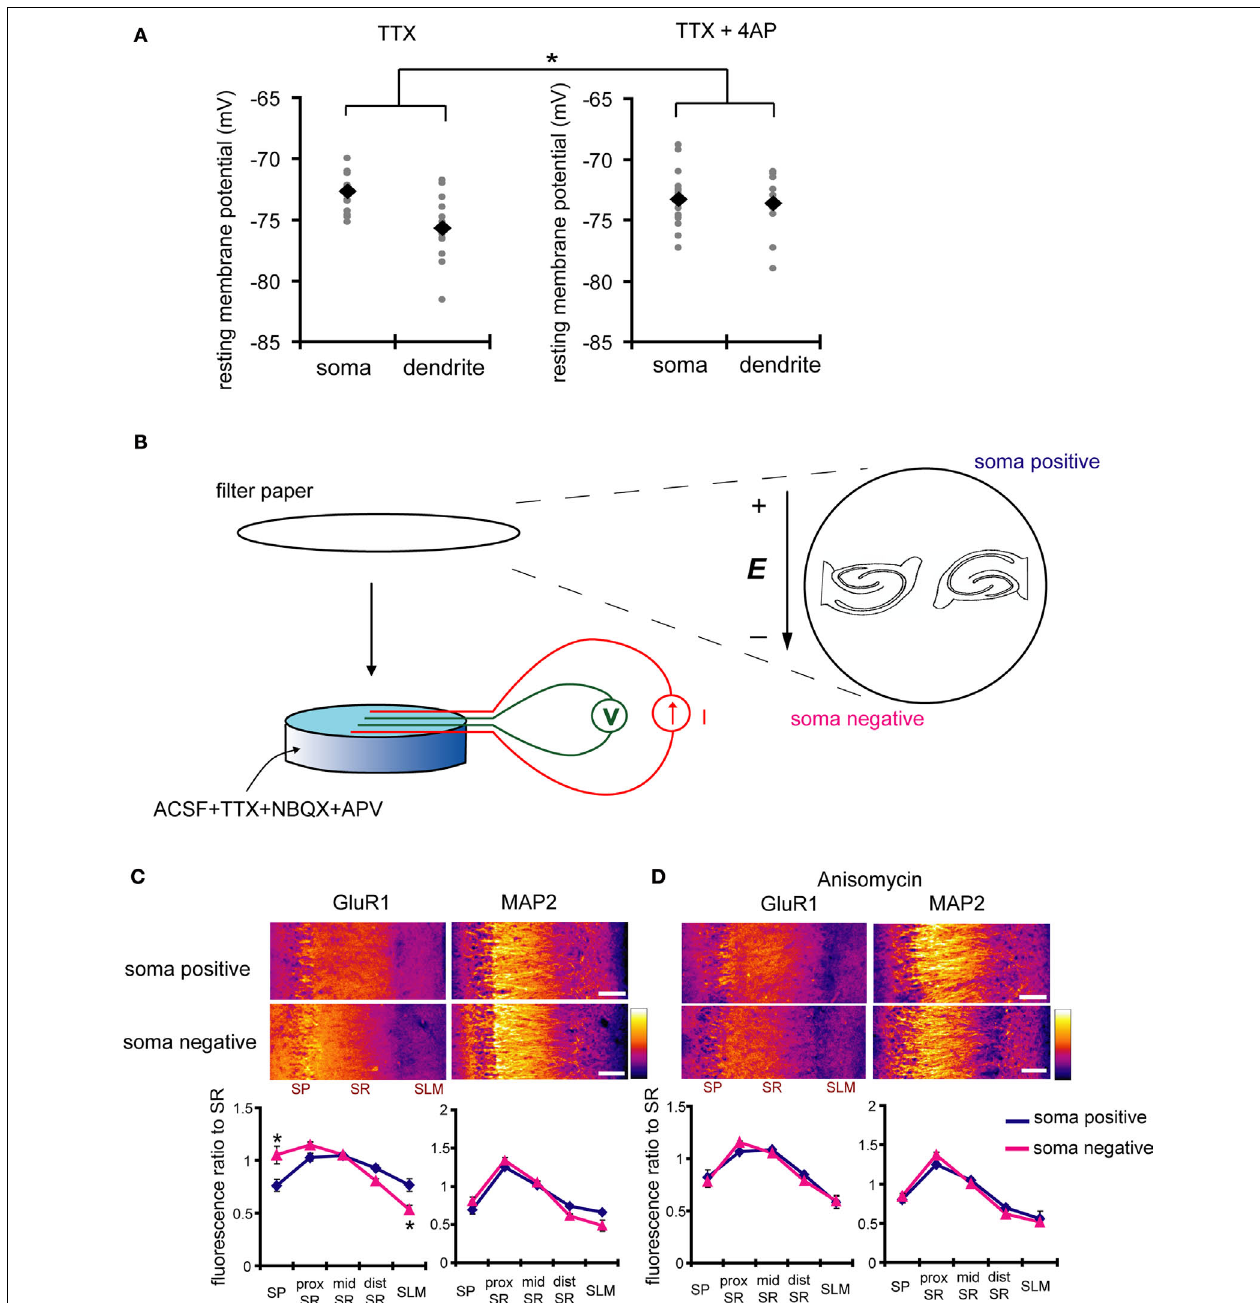
FIGURE 8 | A chronically applied external electric fi eld infl uences GluR1 distribution along the somatic-dendritic axis. (A) Resting membrane potentials measured from individual somata and dendrites of CA1 pyramidal neurons. The recording sites in dendrites were in the distal half of the stratum radiatum (approximately 300–350 µm away from soma). Data from individual experiments are represented by gray circles and black diamonds represent the mean. The application of 4AP (10 mM) abolished the voltage difference between soma and dendrites ( n = 15 for each group) (* p < 0.05 in two-way ANOVA). (B) Scheme of apparatus used for the electric fi eld-application to slices. The external electric fi eld was applied to slices with a current source. The current amplitude was appropriately adjusted by monitoring the voltage difference between the two electrodes using a voltameter. The slices were